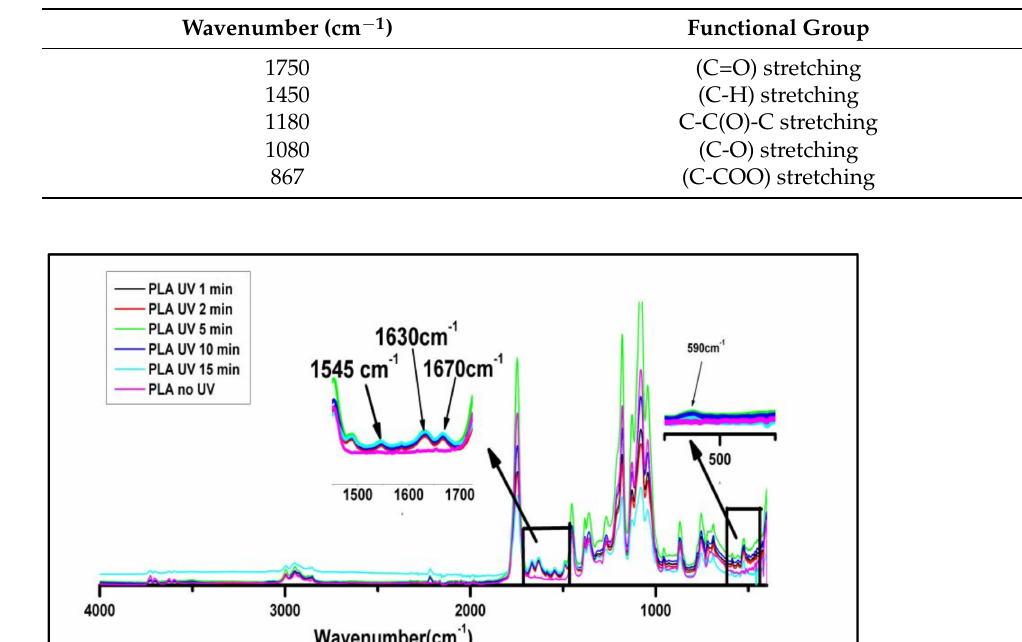
Figure 3. FTIR spectra of PLA tubular scaffolds before and after UV